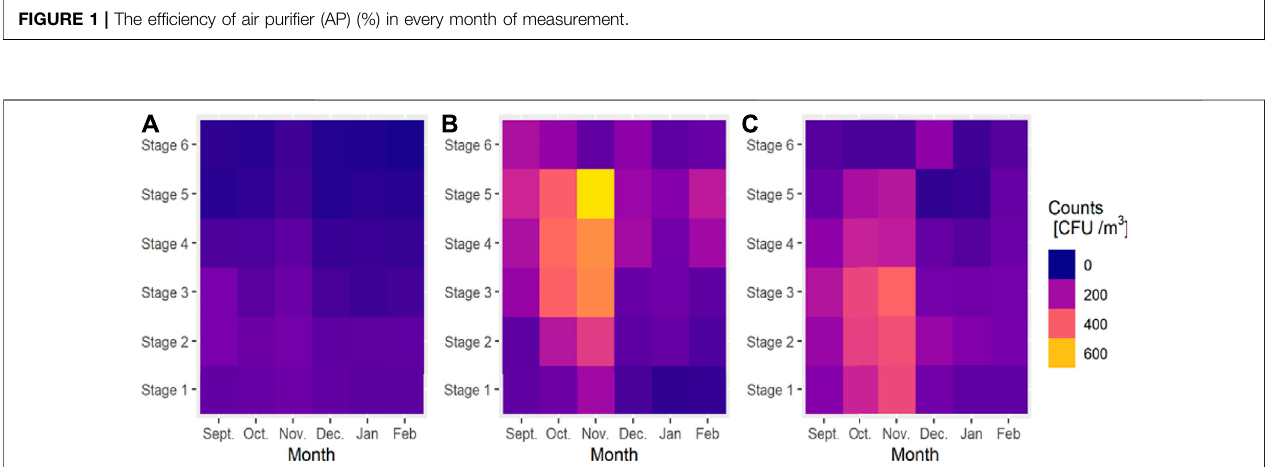
FIGURE 1 | The ef fi ciency of air puri fi er (AP) (%) in every month of measurement.